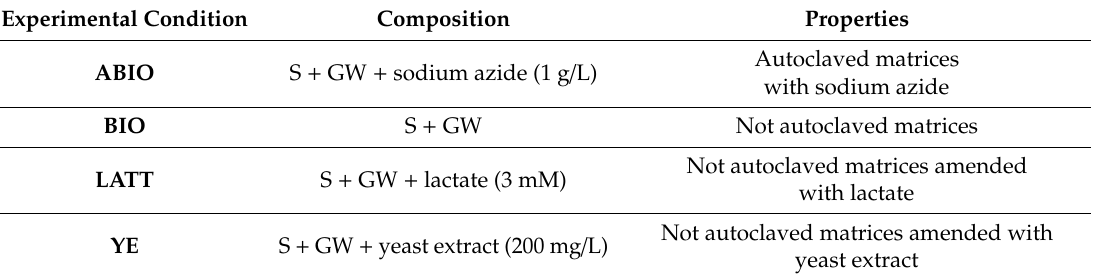
Table 1. Experimental conditions for bottle microcosms. ABIO—soil and water sterilized; BIO—soil and water not sterilized; LATT—with the addition of lactate; YE—with the addition of yeast extract; S—limestone;